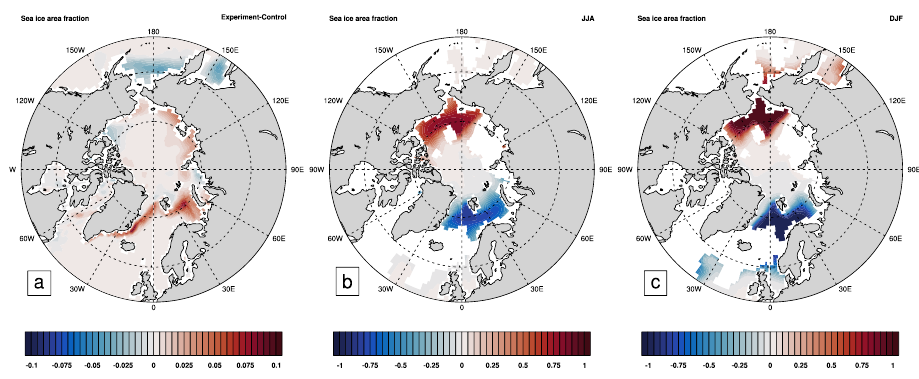
Figure A3. The changes in sea ice area fraction in the Northern Hemisphere due to sustained RRM: